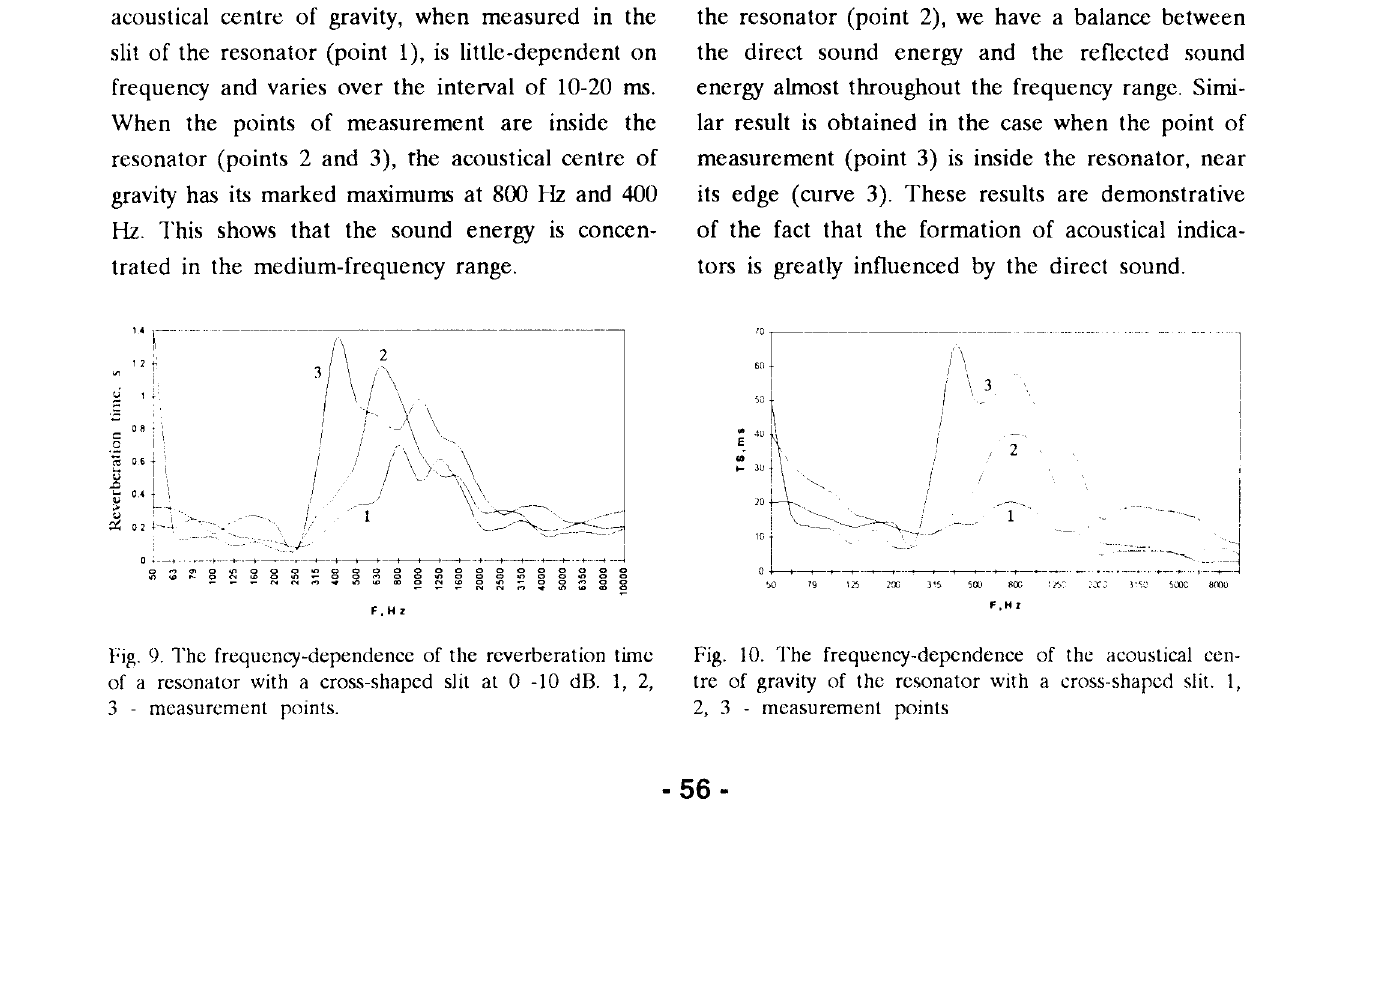
Fig. 10. The frequency-dependence of the acoustical cen tre of gravity of the resonator with a cross-shaped slit. 1, 2, 3 - measurement